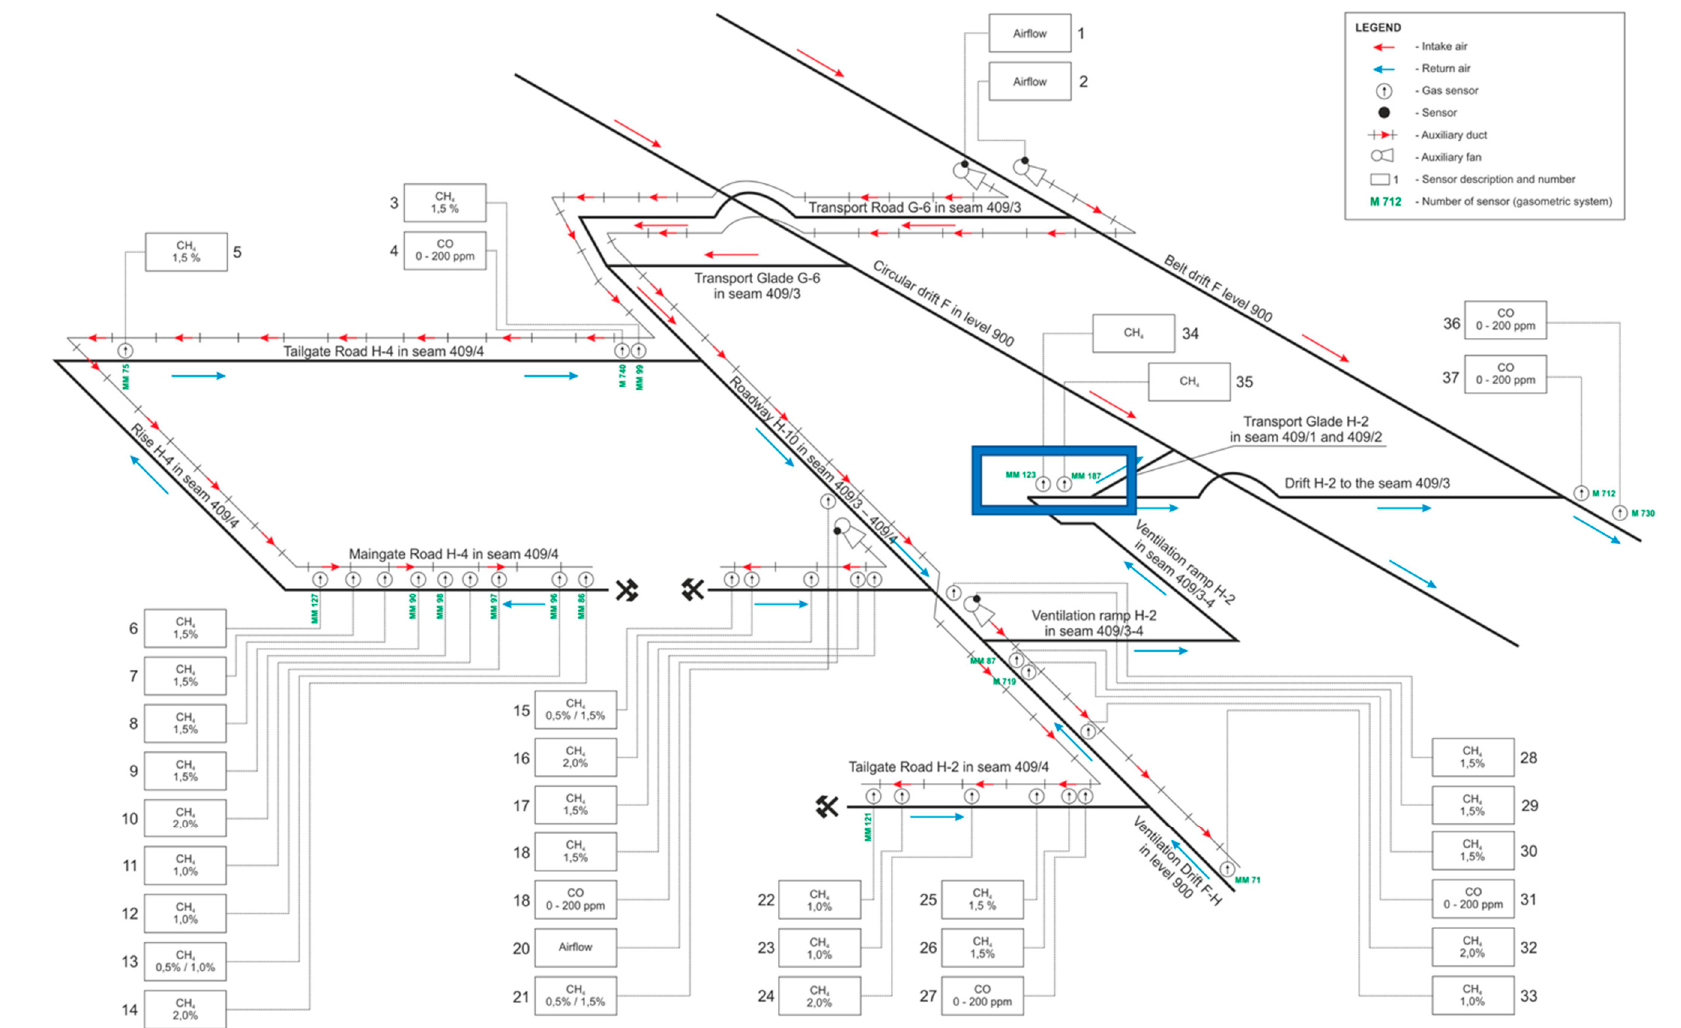
Figure 3. Diagram of the gasometric system and ventilation in the area of longwall H-4 in seam 409/4.